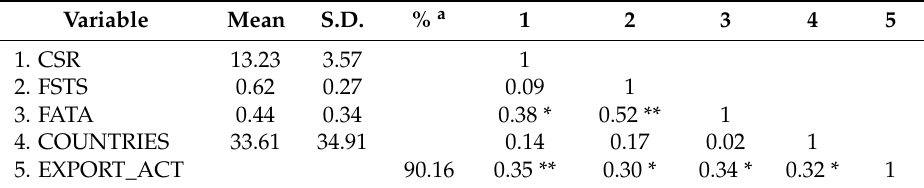
Table 3. Descriptive statistics and correlation matrix.